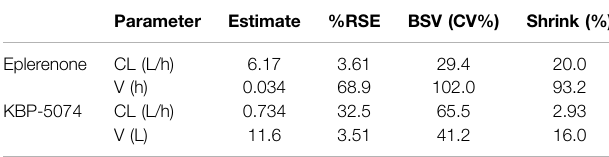
TABLE 3 | PK/PD modeling analysis: PD parameters for eplerenone and KBP- 5074 for serum K + and